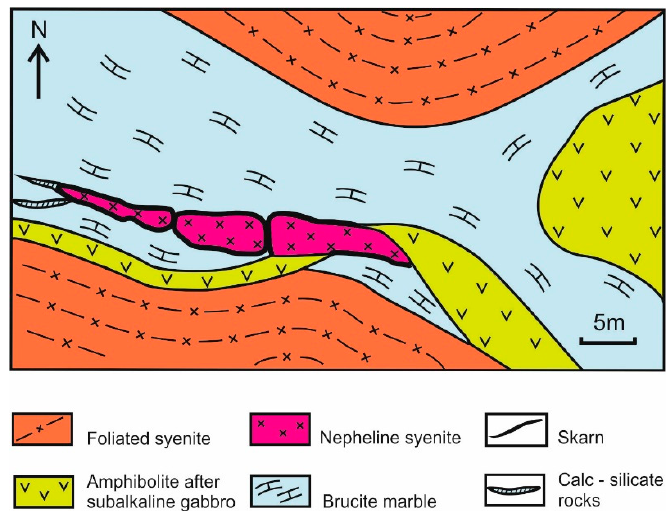
Figure 6. Detailed geologic map of site 4, modified after [24].